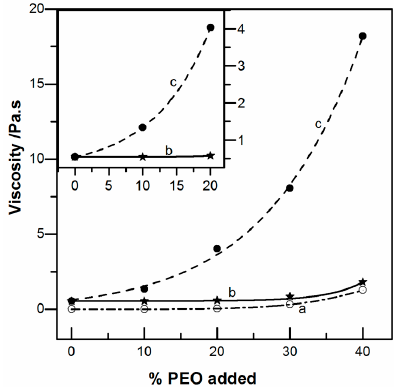
Figure 2. Variation of the viscosity at 0.5 s − 1 of added PEO (M = 1000 kg/mol) expressed in percent of total polymer concentration in the mixtures. (a) PEO solution in 0.5 M acetic acid ; (b) additivity calculated for each values of “a” added into pure chitosan CS-102 and (c) blends chitosan CS-102/PEO as a function of the weight fraction of PEO . ○